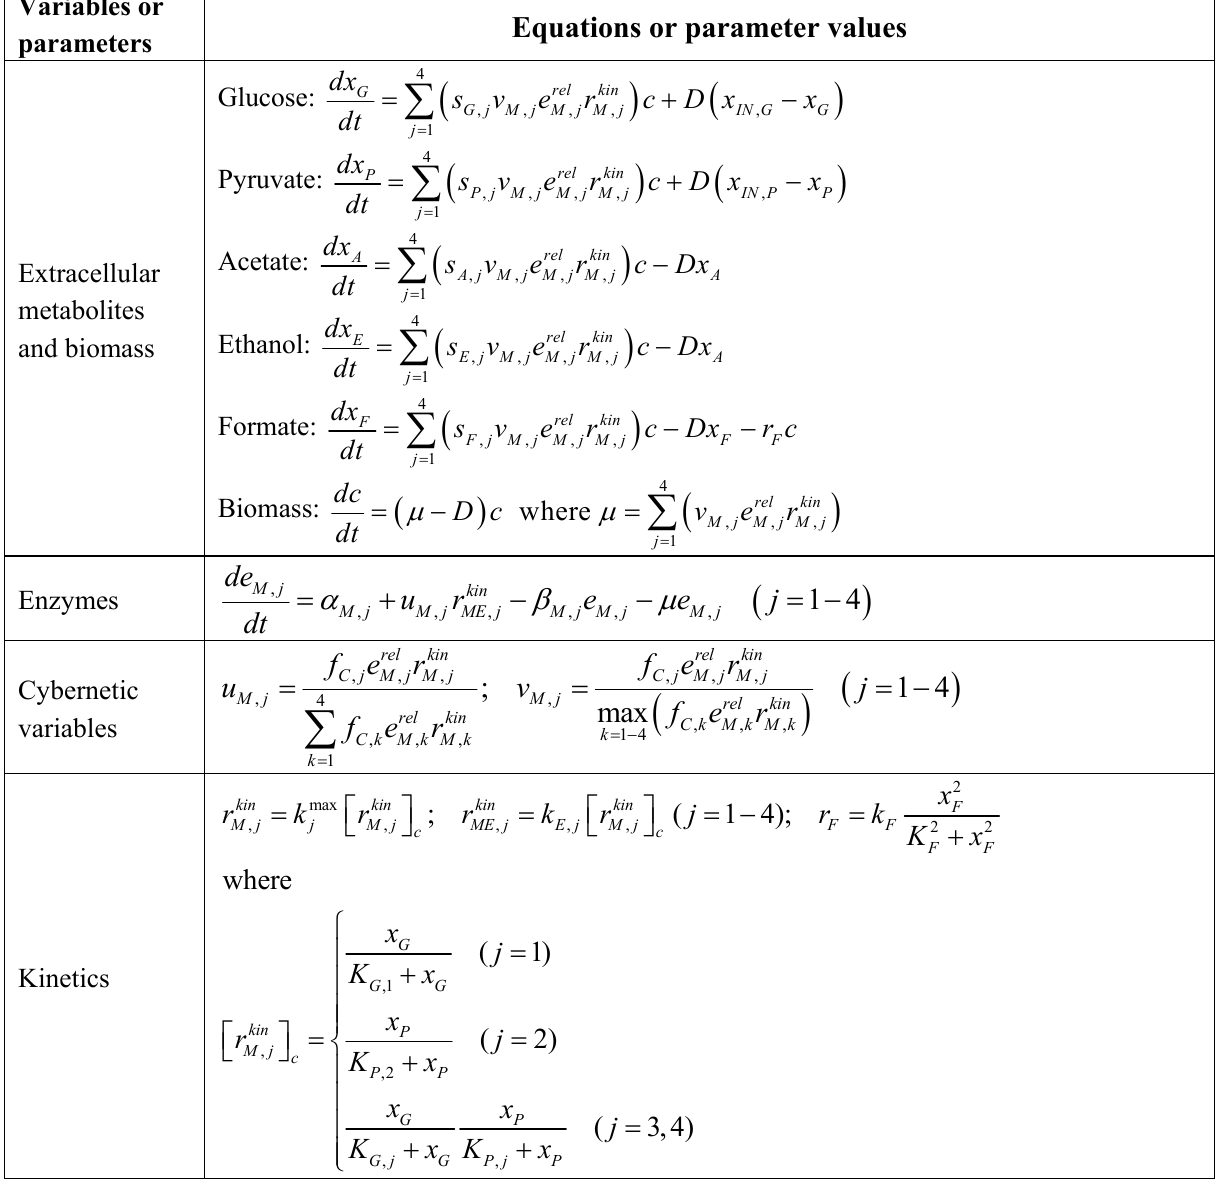
Table 1. Model equations and parameter values. EM, elementary